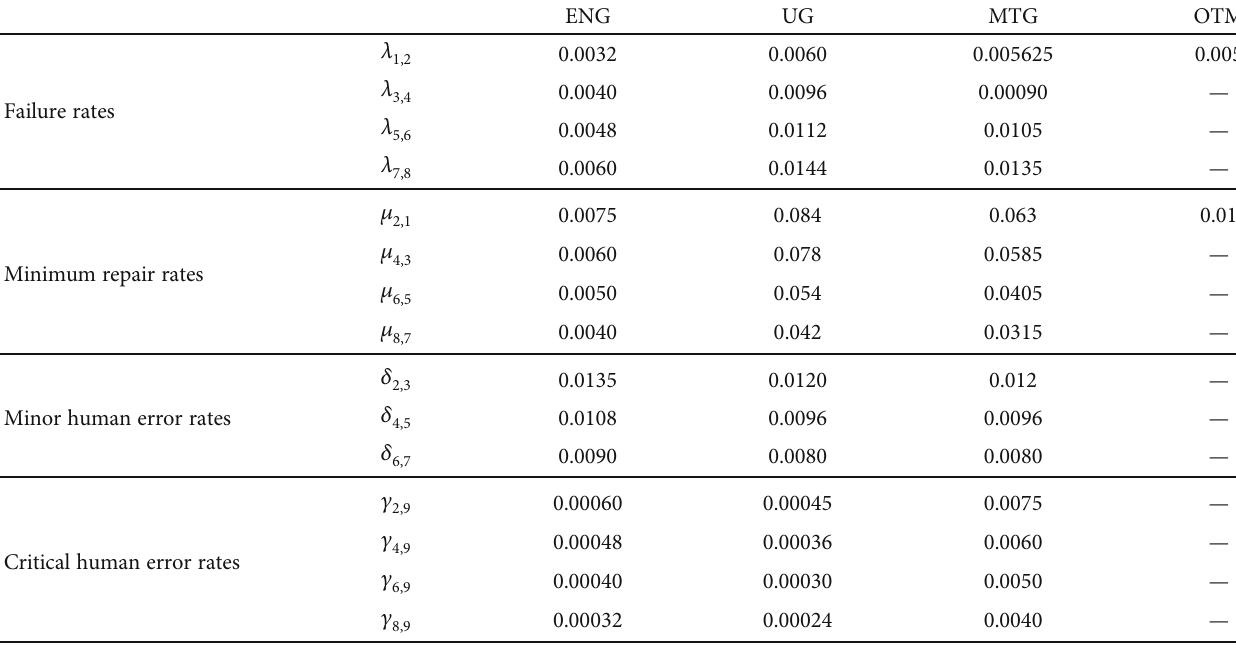
Table 2: Transition rates of assemblies with exponential